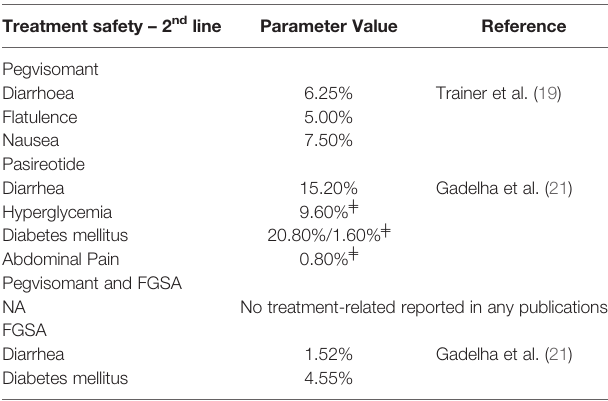
TABLE 3 | Treatment safety